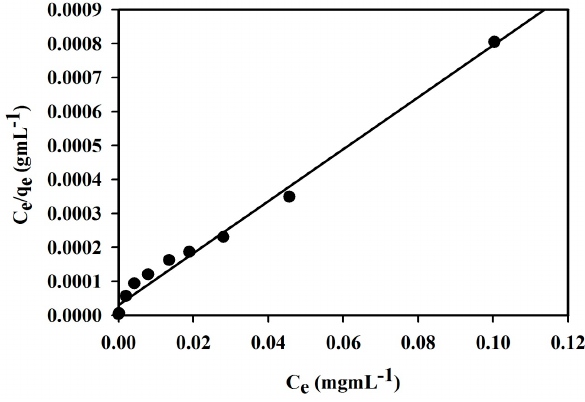
Figure 5. Langmuir adsorption isotherm model of Zr(IV) adsorption on 20 mg Langmuir adsorption isotherm model of Zr(IV) adsorption on 20 mg SG-APTMS-N,N-EPANTf 2 at pH 4.0 and 25 °C. Adsorption experiments were performed using SG-APTMS-N,N-EPANTf 2 at pH 4.0 and 25 ˝ C. Adsorption experiments were different concentrations (0–200 mg·L − 1 ) of Zr(IV) under batch conditions.